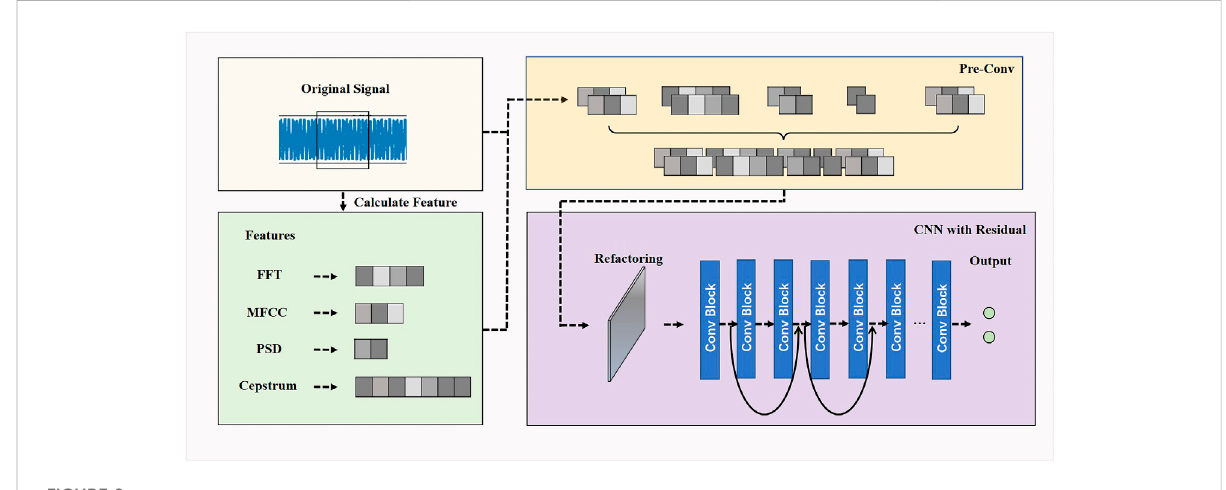
FIGURE 9 CNN with both pre-convolution and